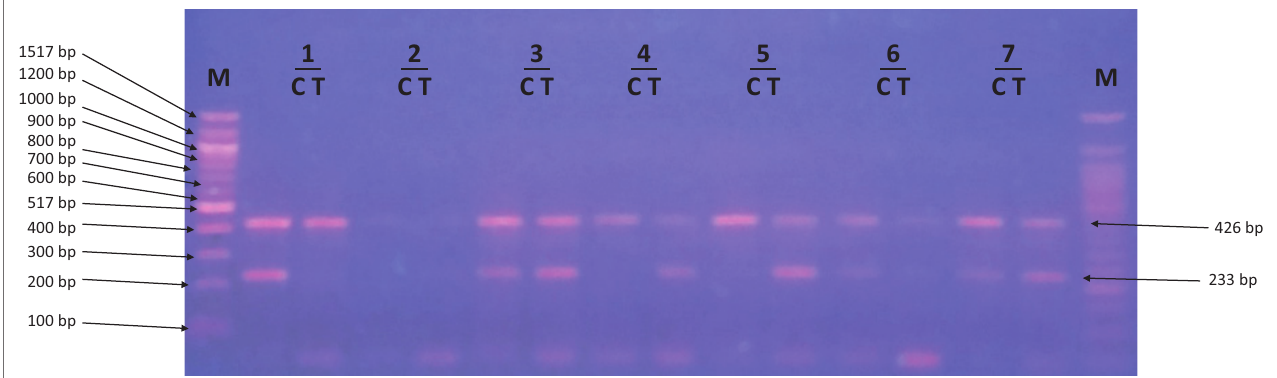
FIGURE 1: Amplicons for interleukin-10 -819 C/T single nucleotide polymorphism. Lane M shows 100 base pair (bp) molecular marker. The 426 bp fragments correspond to the internal control (the human growth hormone gene). The 233 bp fragments were specific for C and T alleles of IL-10 -819 C/T single nucleotide polymorphisms. Lanes labelled 3, 6 and 7 show heterozygous CT genotypes. Lanes labelled 1 and 4 show homozygous CC and TT genotypes, respectively.